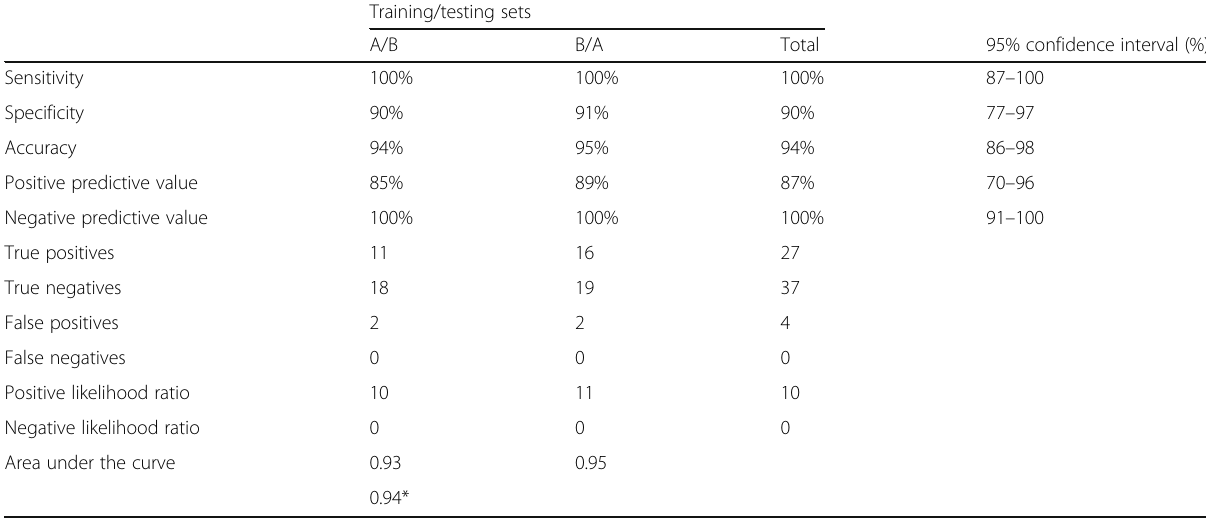
Table 4 Diagnostic performance of the TWIST algorithm